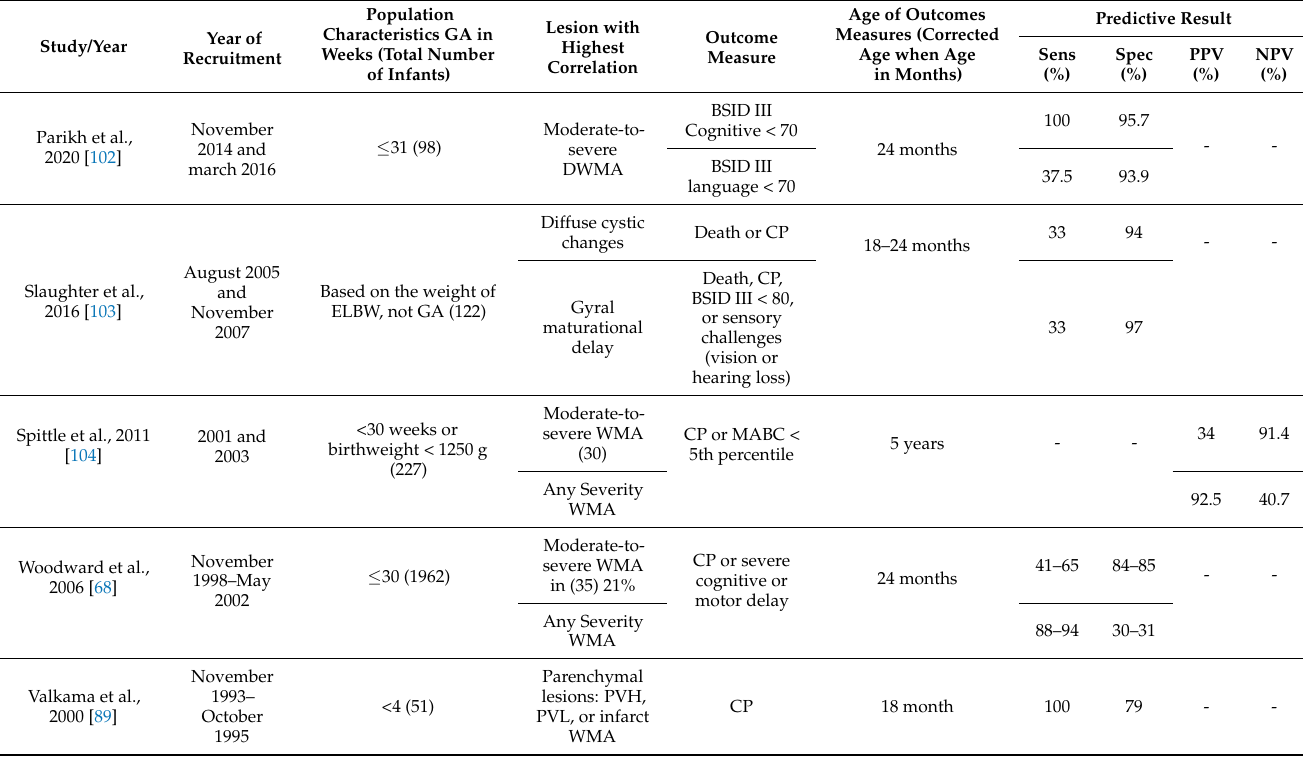
Table 3. The predictive value of the MRI at TEA in preterm